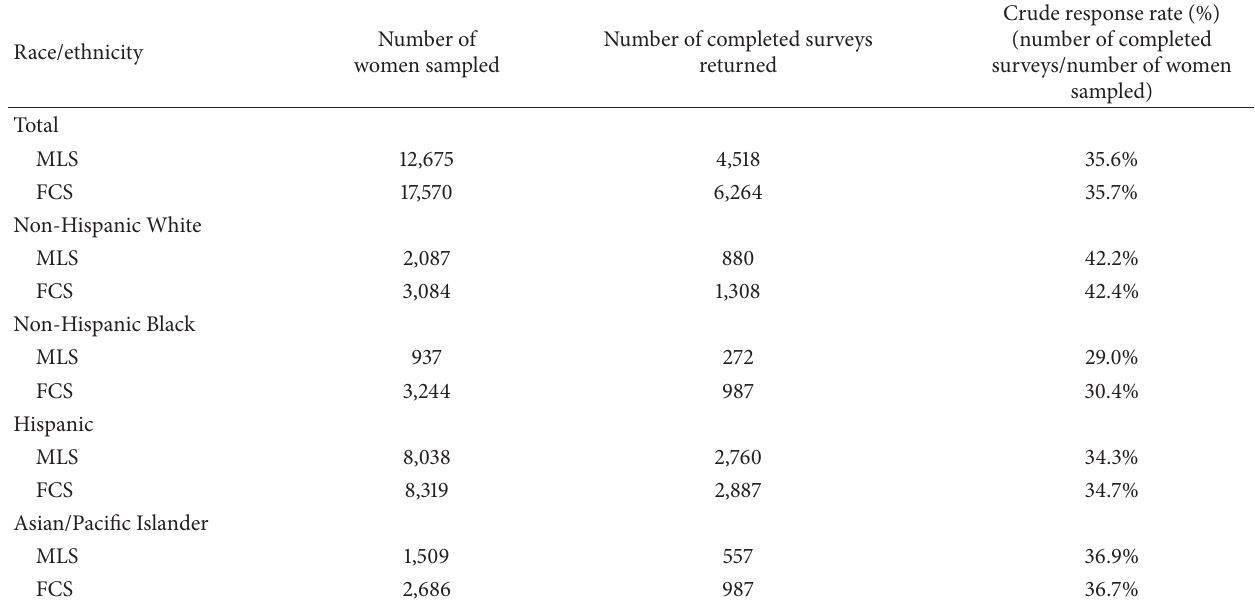
Table 2: Comparison of 2007 LAMB surveys sent and completed by race-ethnicity among the multilevel (MLS) and final county (FCS) samples (crude response